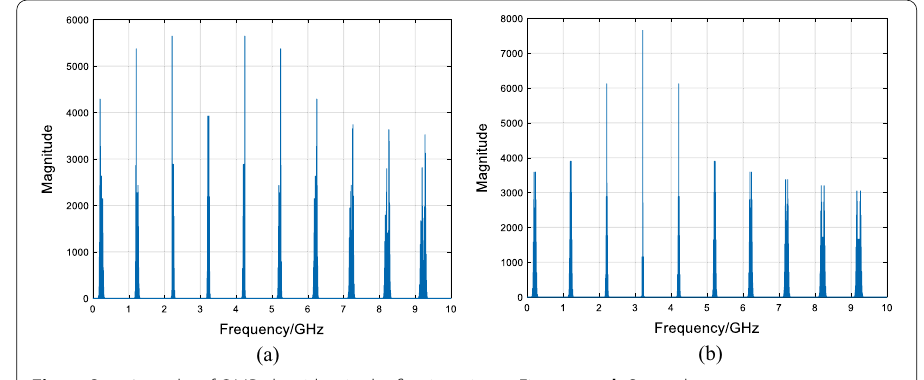
Fig. 4 Step 2 results of OMP algorithm in the first iteration. a First group, b Second group